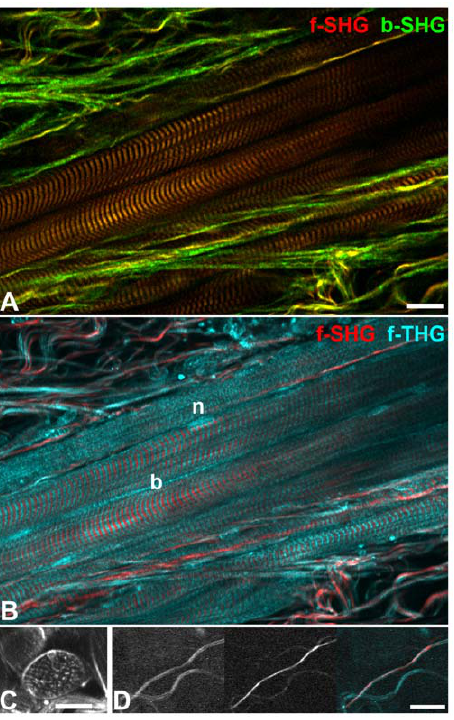
Figure 1. Collagen fibers and striated muscle. A) The relative SHG signal intensity ratio collagen/myosin is higher in backward SHG (green) than in forward SHG (red). B) While in striated muscle SHG visualizes myosin and thus A-bands of the sarcomeres, THG signals are from the interjacent I-bands as well as from the muscle fiber border (b) and muscle cell nuclei (n). C) Forward THG signal of a muscle fiber running parallel to the optical axis, single optical section. The fiber border is delineated by a surrounding THG signal. The small bubble at the upper fiber border may belong to a cell nucleus. No SHG signal was detected in this case. D) Thick collagen fiber producing a double signal in THG (left, cyan in overlay) which is filled by the SHG signal (center, red in overlay). Scale bars 20 m